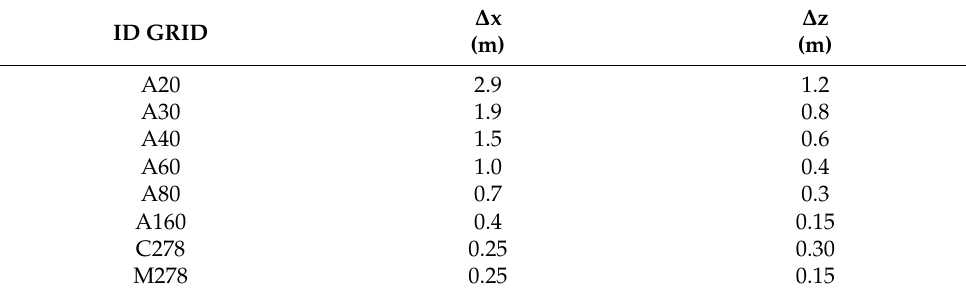
Table 5. Characteristics of grids used for sensitivity analysis.